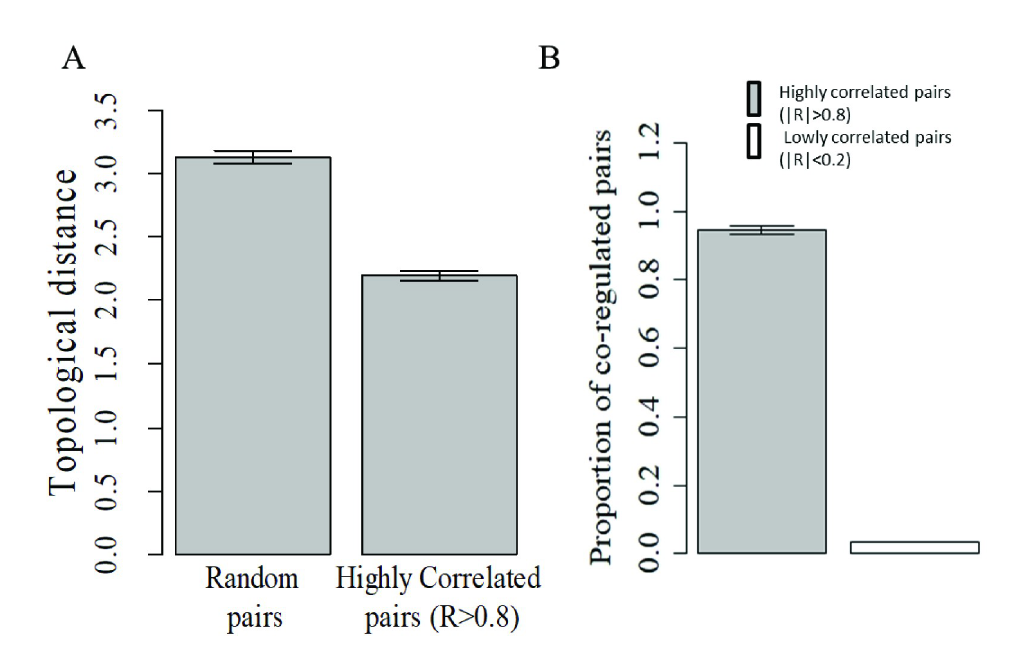
Fig 5. Correlated pairs of genes share common regulators in synthetic GRN. A) Typical average topological distance (a measure of regulatory proximity in the GRN) between pairs of highly correlated genes (/R/ > 0.8) compared with the average distance between random pairs of background genes in the synthetic regulatory network. In both cases, the associated p value in a T test was below 10–16. B) Bar chart showing the average proportion ( ± S.E.M) of pairs of genes sharing a common regulator among either highly correlated pairs (/R/ > 0.8) or lowly correlated pairs (/R/ < 0.2) found in 1000 independent